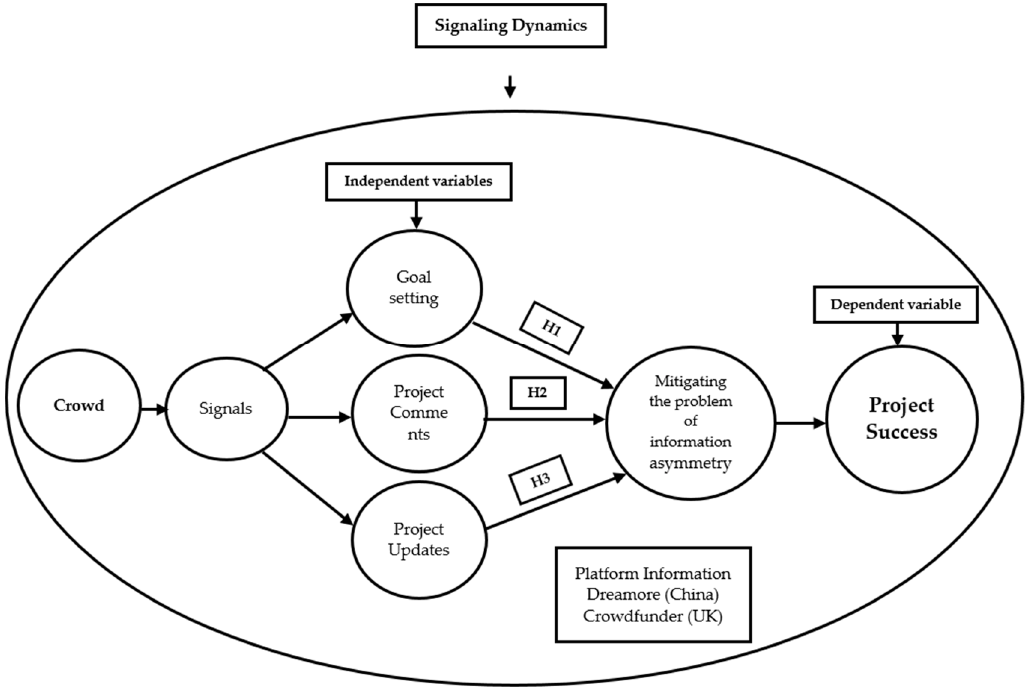
Figure 1. Theoretical framework.